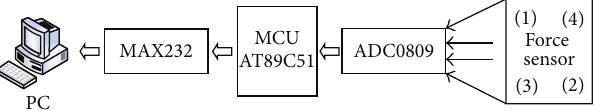
Figure 17: The foot supporting force measurement unit.